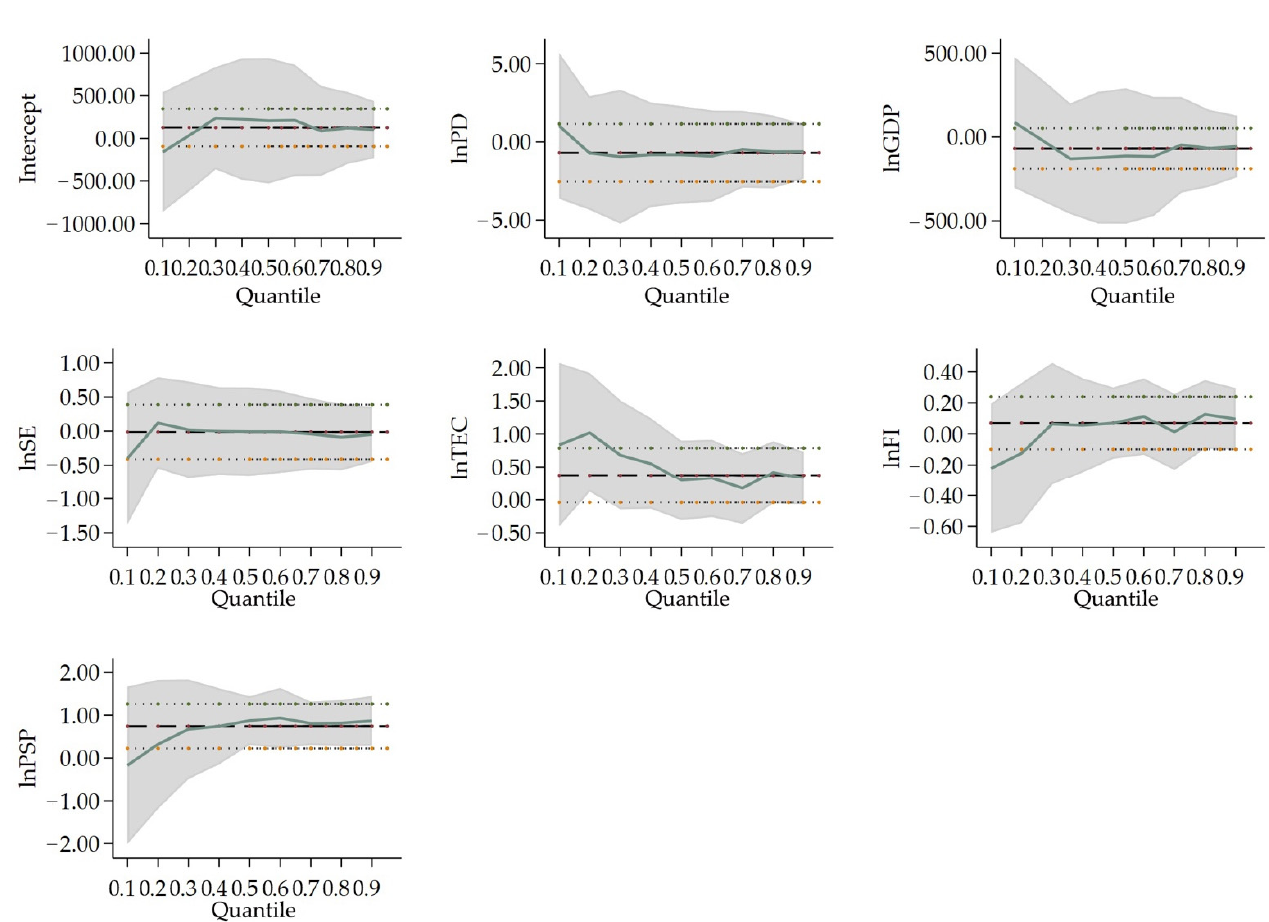
Figure 5. Change in variables’ coefficients in Type IV cities’ quantile regression. Notes: the labels for all lines, the horizontal and vertical axis are the same as above.